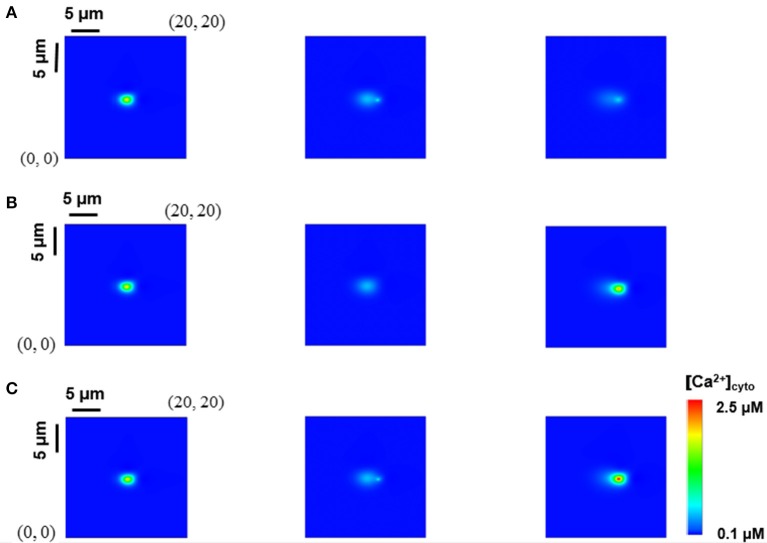
Interplay of rogue and clustered RyRs in neighbor JSRs. Snapshots of Ca2+ release events in a computational region of 20 × 20 μm2 were taken at 10, 20, and 40 ms from left to right when a CRU of clustered RyRs was fired. (A) Rogue RyRs in a neighbor JSR are activated. (B) Clustered RyRs in a neighbor JSR are initiated by a Ca2+ spark directly. (C) Clustered RyRs are triggered with the help of rogue RyRs.